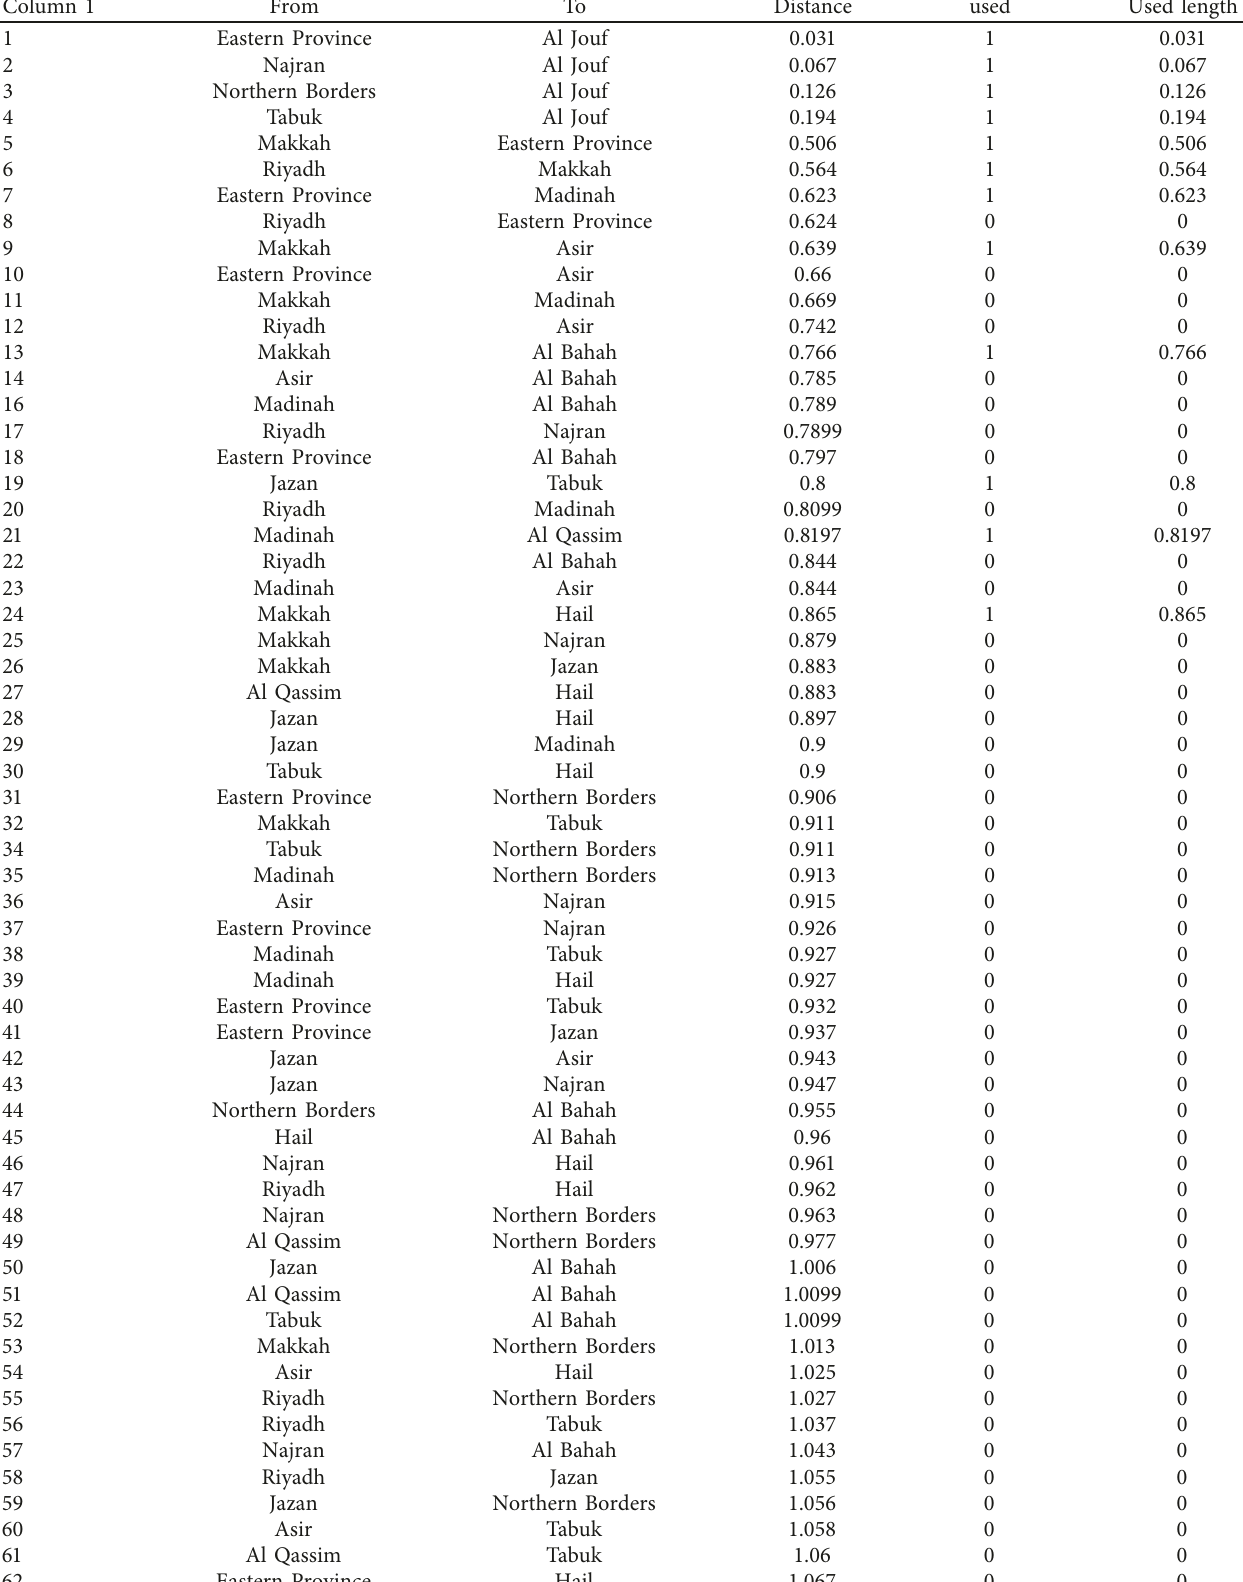
Table 6: MST output format according to Pajek’s